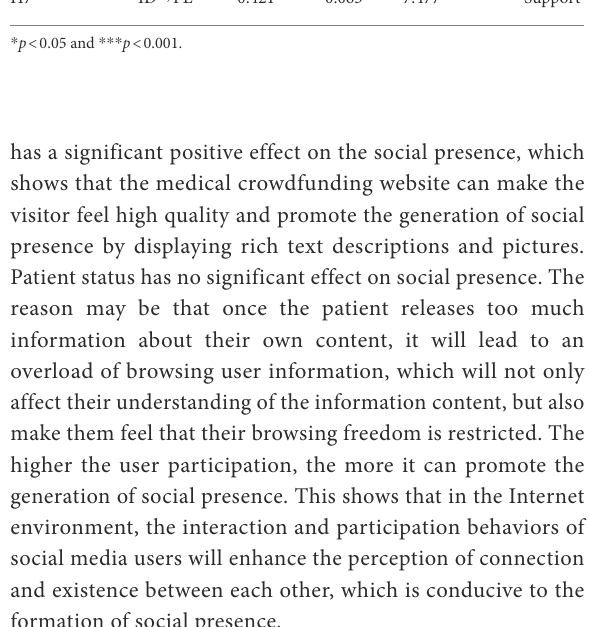
TABLE 3 Fit index of this model.